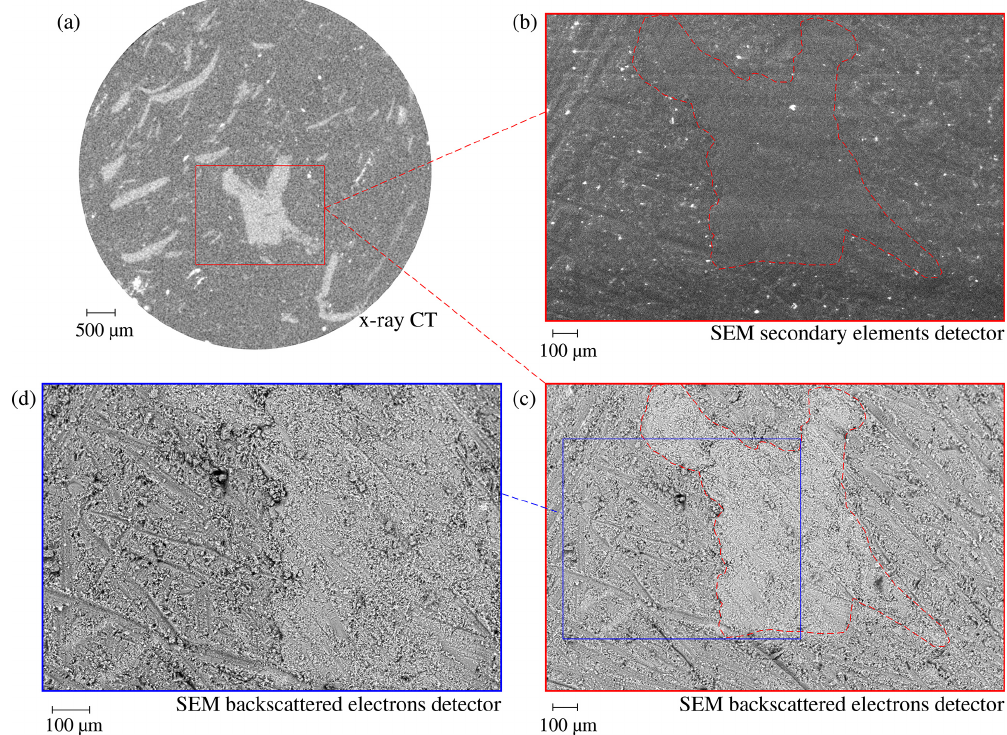
Figure 6. Horizontal slice of the Opalinus Clay sample A from different imaging tools: (a) X-ray computed tomography, (b) correspond- ing SEM slice scanned with a secondary-element detector, (c) corresponding SEM slice scanned with a backscattered-electron detector (d) magnified selected region of (c)